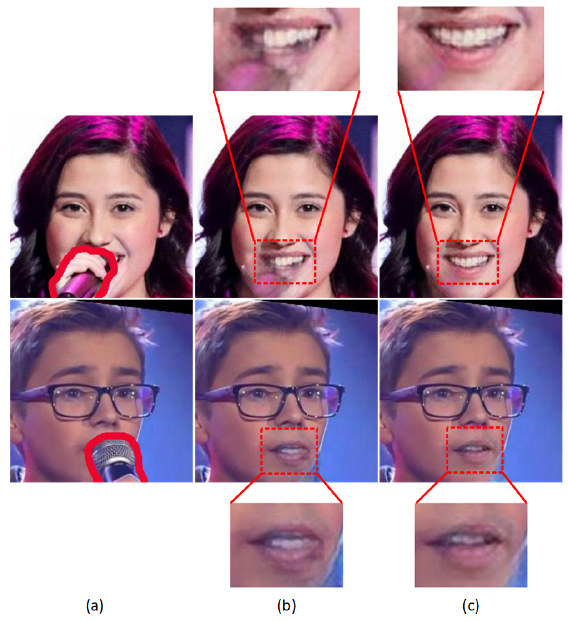
Figure 9. The effect of dilated convolution. ( a – c ), input mic images I mic , output of the network without dilated convolution and with dilated